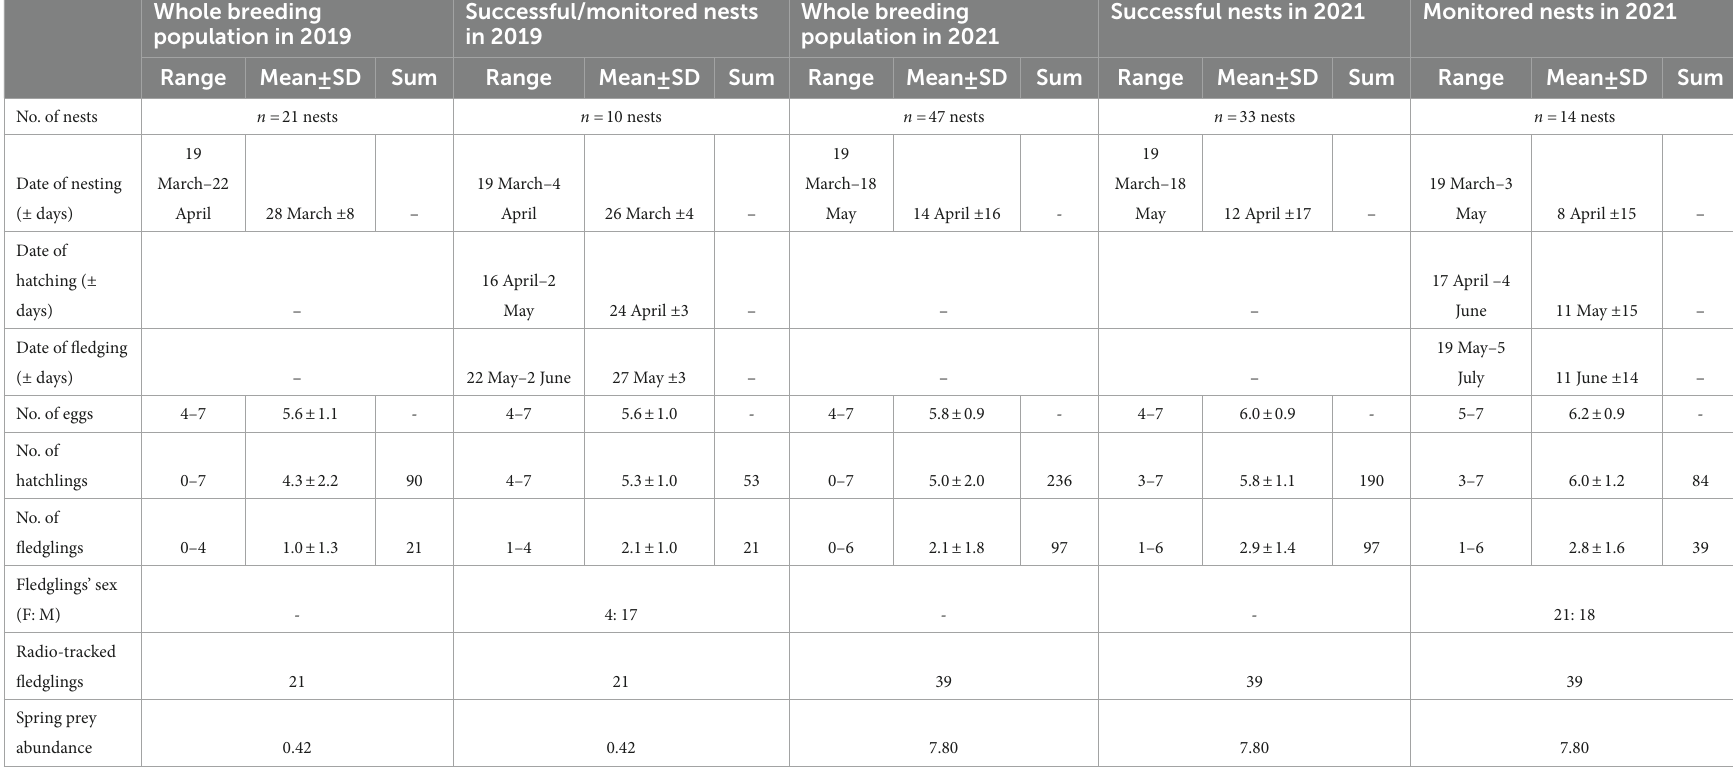
Successful nests in 2021 Monitored nests in 2021